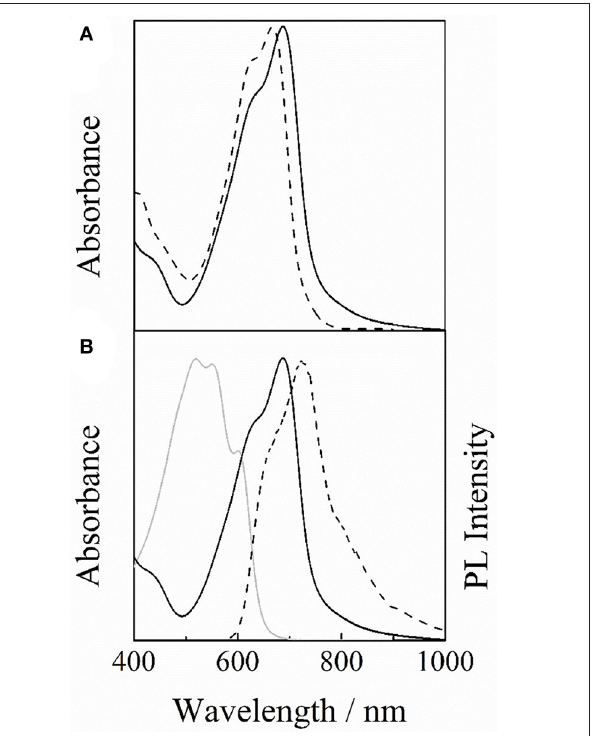
FIGURE 3 | (A) Absorption spectra of PCDPP4T in chloroform solution (broken line) and in solid film on a quartz substrate (solid line). (B) Absorption spectra of P3HT (gray solid line) and PCDPP4T (black solid line), and photoluminescence (PL) spectrum of P3HT (black broken line).